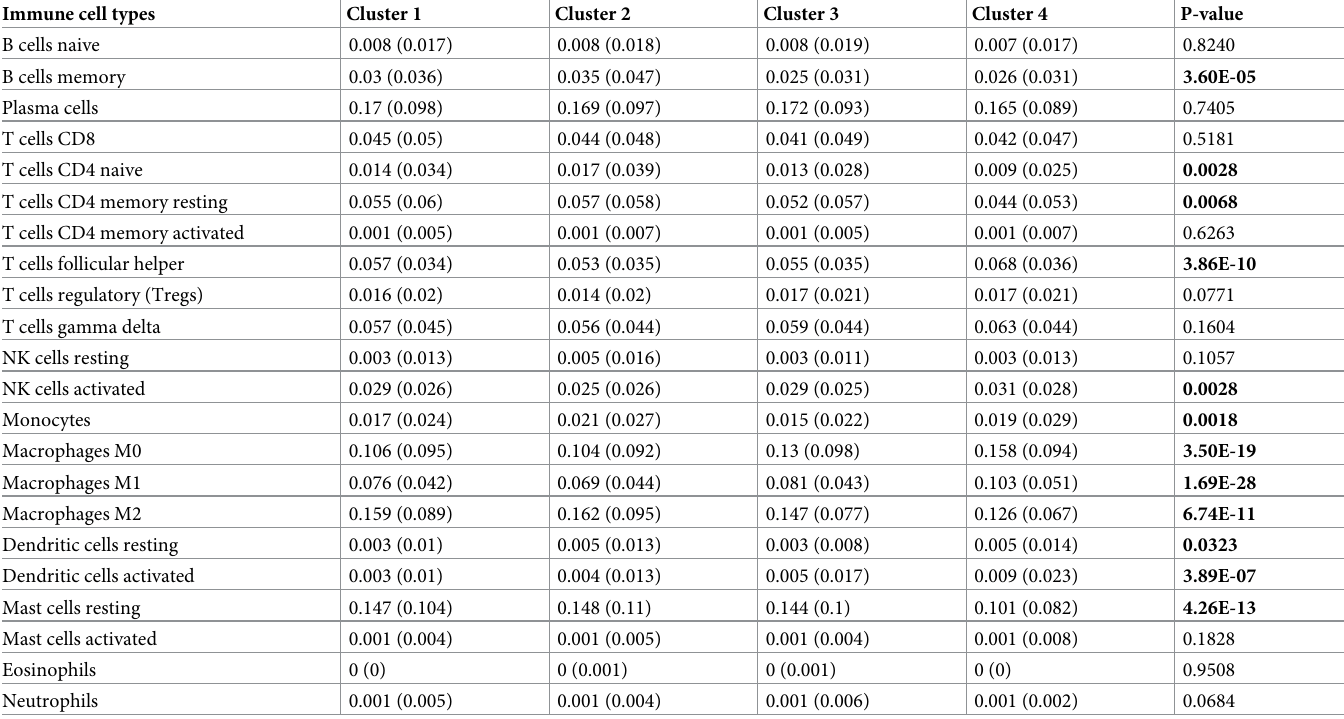
Table 2. Comparison of 22 CIBERSORT immune cell types among the four clusters identified in METABRIC, showing mean (standard deviation) values. Immune cell